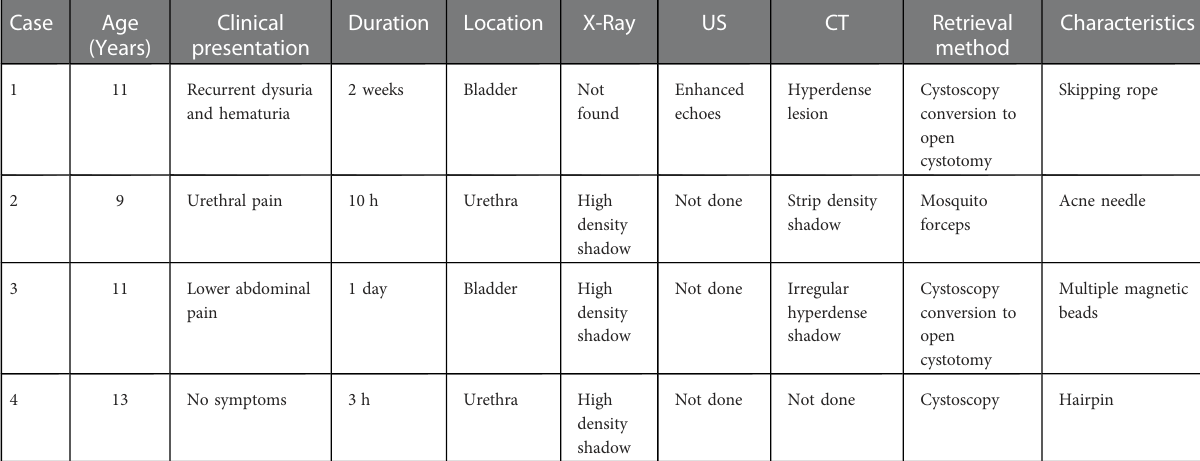
TABLE 1 Characteristics of the lower urinary tract foreign bodies and their